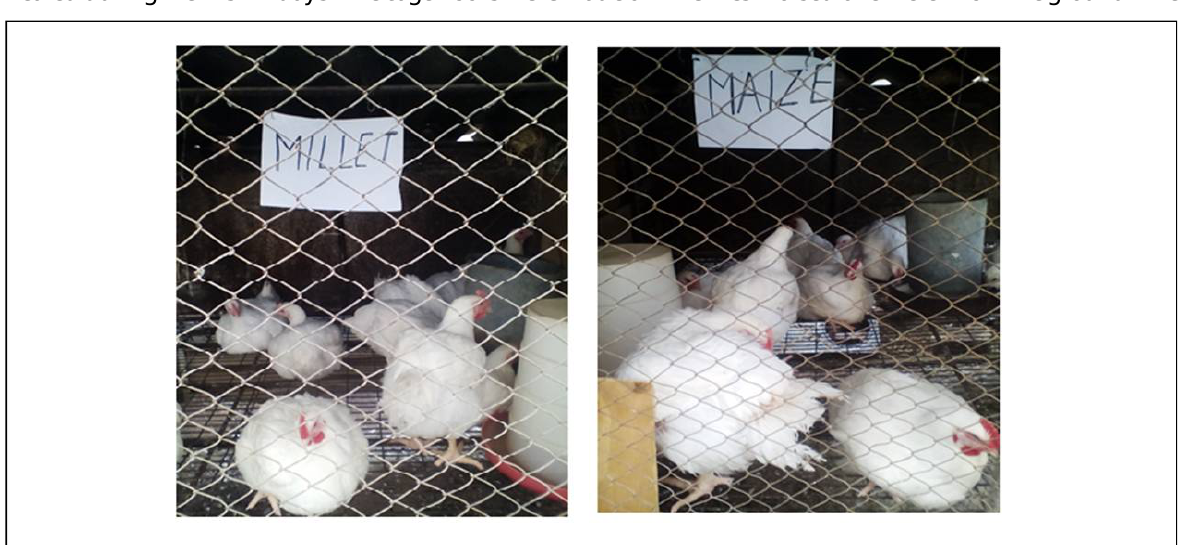
Figure 1: (a) Finger millet fed broiler cage. (b) Maize fed broiler